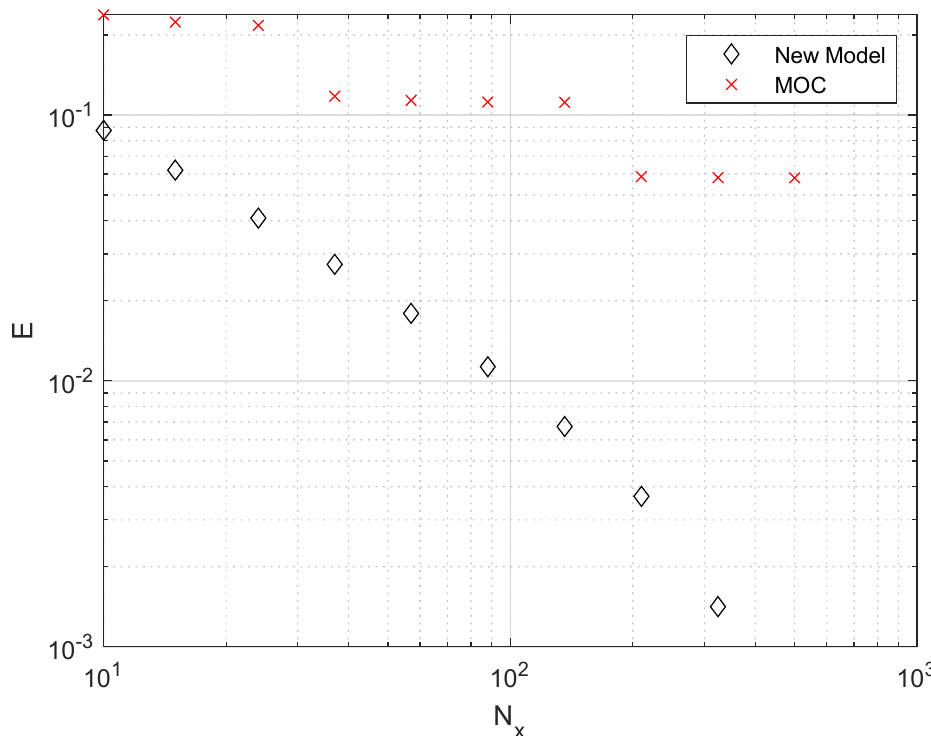
Figure 12. Normalized error for the same data as Figure 11.